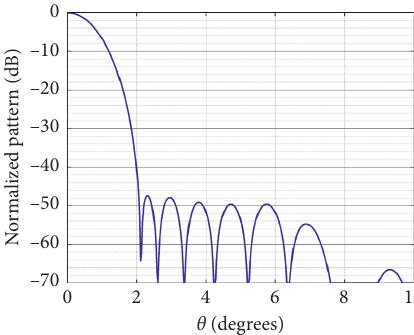
Figure 11: The array pattern for N � 75, and M � 45. 2nd and 3rd � 71, M � 37 and N � 51 t r nulls are at the same position.